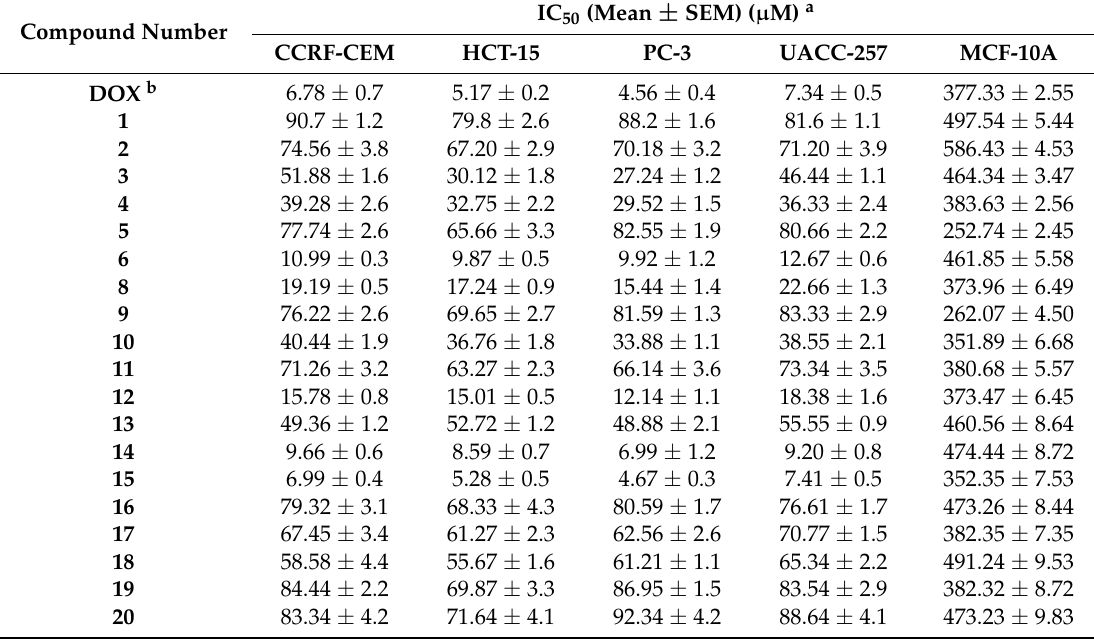
Table 2. In vitro cytotoxic activity of the tested compounds 1 – 20 against different human cancer cell